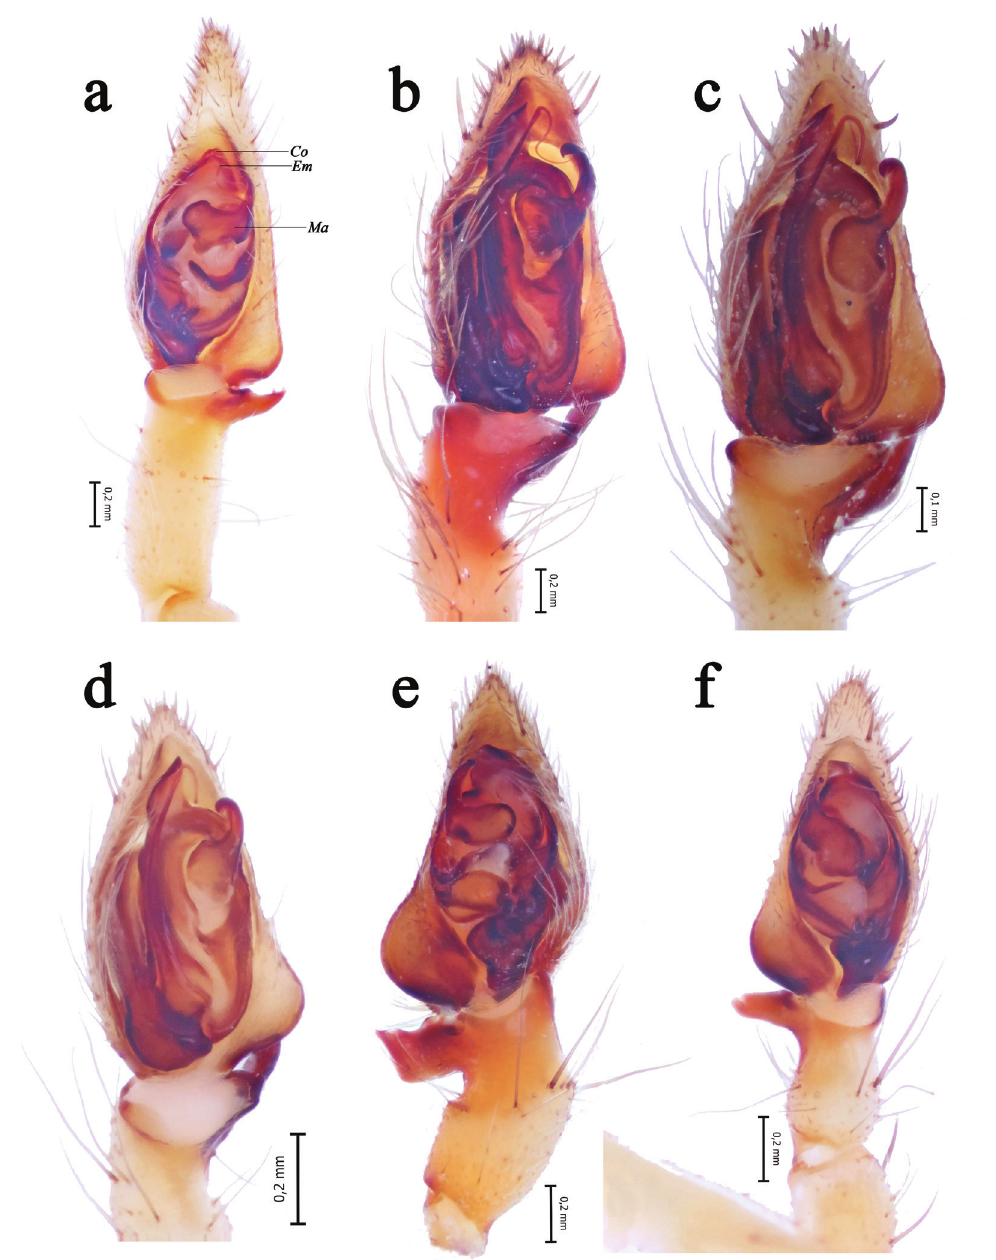
Figure 2. Ventral views of the male palps of Pterotricha spp.: a ) P. arabica sp. n.; b ) P. esyunini sp. n.; c ) P. nadolnyi sp. n.; d ) P.